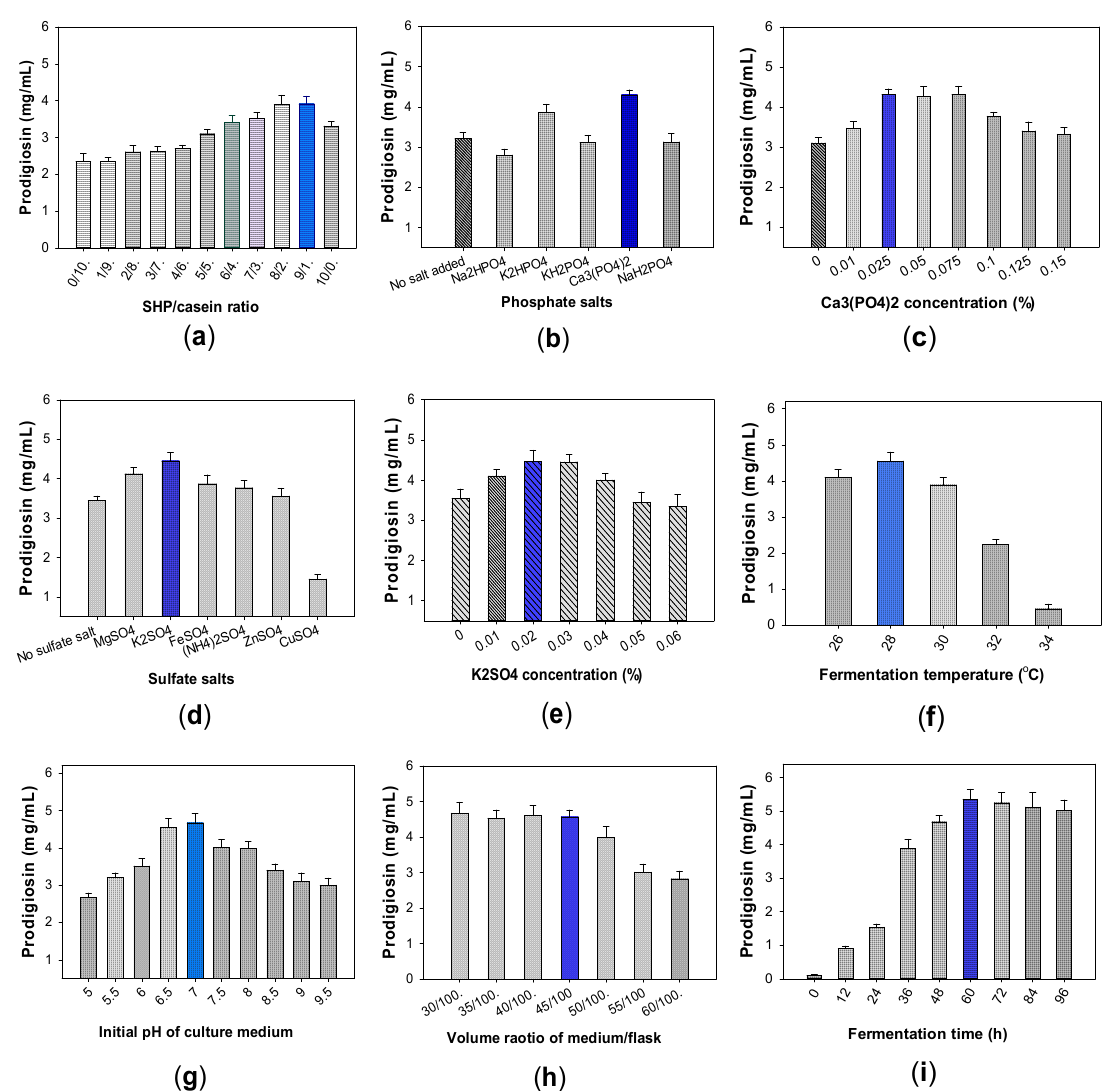
Figure 1. The effect of the SHP/casein ratio ( a ), sources of phosphate salt ( b ), Ca 3 (PO 4 ) 2 concentration ( c ), sources of sulfate salt ( d ), K 2 SO 4 concentration ( e ), temperature of cultivation ( f ), the starting pH of culture broth ( g ), volume ratio of culture broth/flask ( h ), and the time duration of cultivation ( i ). Standard errors (SE) are shown by the error bars in all the figures. The blue bars indicate the parameters chosen for further